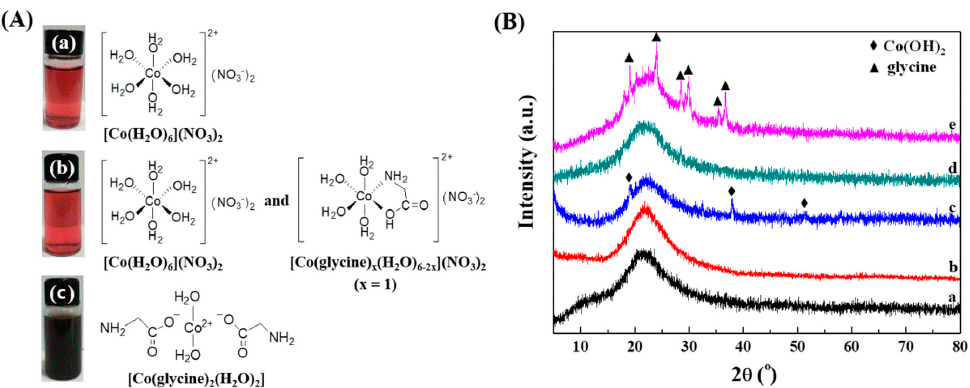
Figure 1. ( A ) the colors, characters, and structures of the impregnating solution of [Co(H 2 O) 6 ](NO 3 ) 2 ( a ), [Co(H 2 O) 6 ](NO 3 ) 2 and [Co(glycine) x (H 2 O) 6 − 2x ](NO 3 ) 2 ( b ), and [Co(glycine) 2 (H 2 O) 2 ] ( c ); ( B ) XRD patterns of the uncalcined catalysts for Co / SiO 2 (a), Co-3gly / SiO 2 (b), Co(1gly) / SiO 2 (c), Co(3gly) / SiO 2 (d), and Co(5gly) / SiO 2